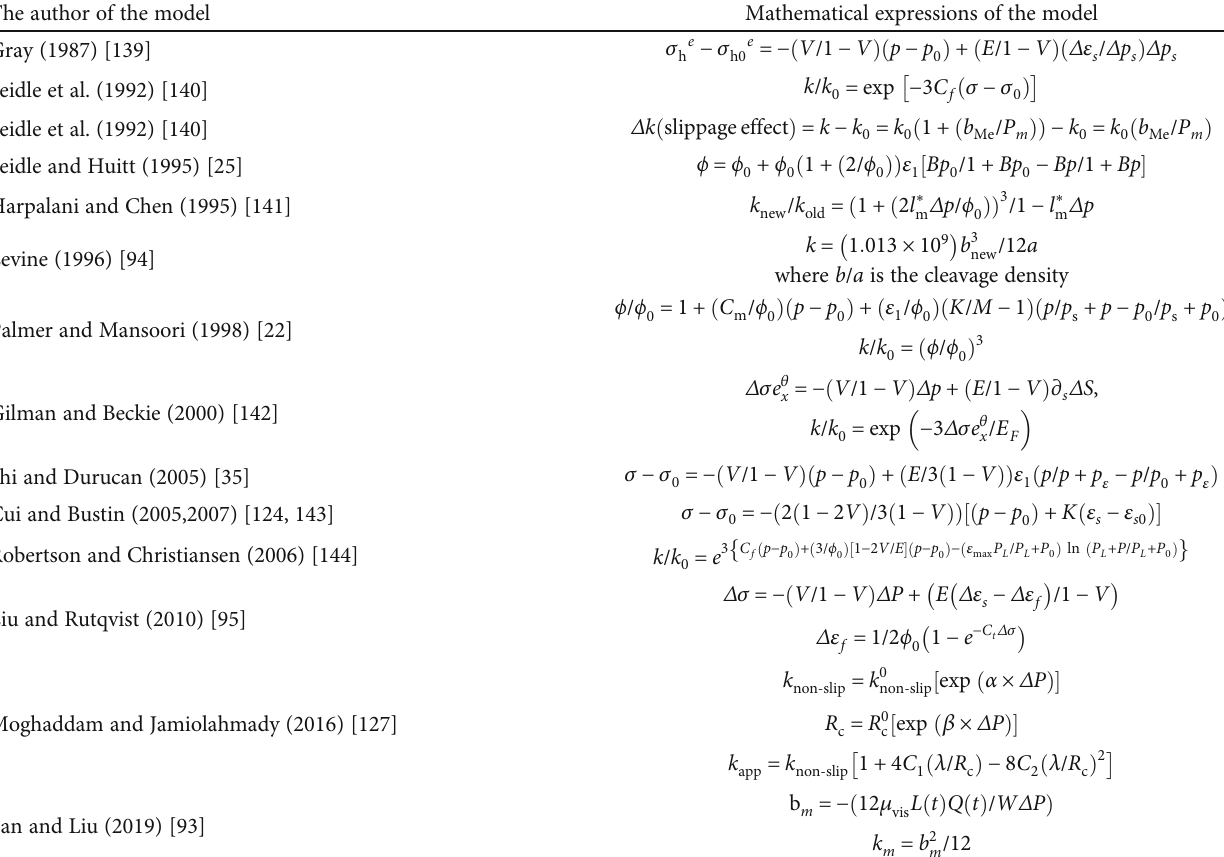
Table 4: Permeability prediction models and mathematical expressions of coal